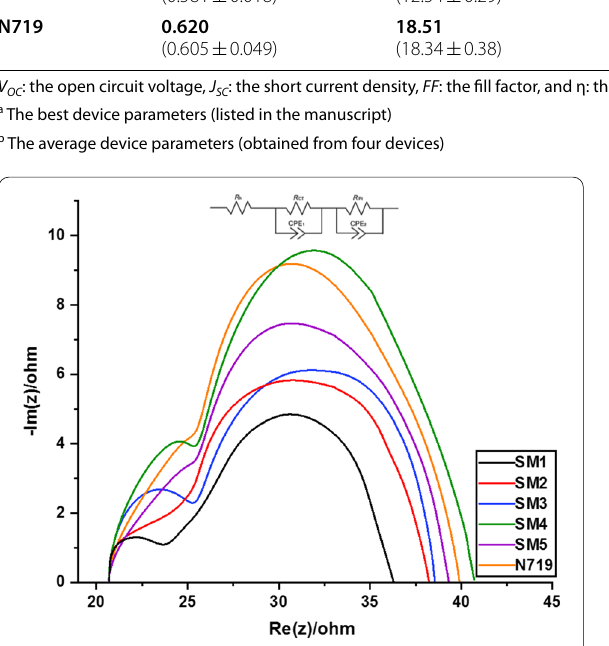
Fig. 10 Nyquist plots of SM1‑5‑ and N‑719‑based